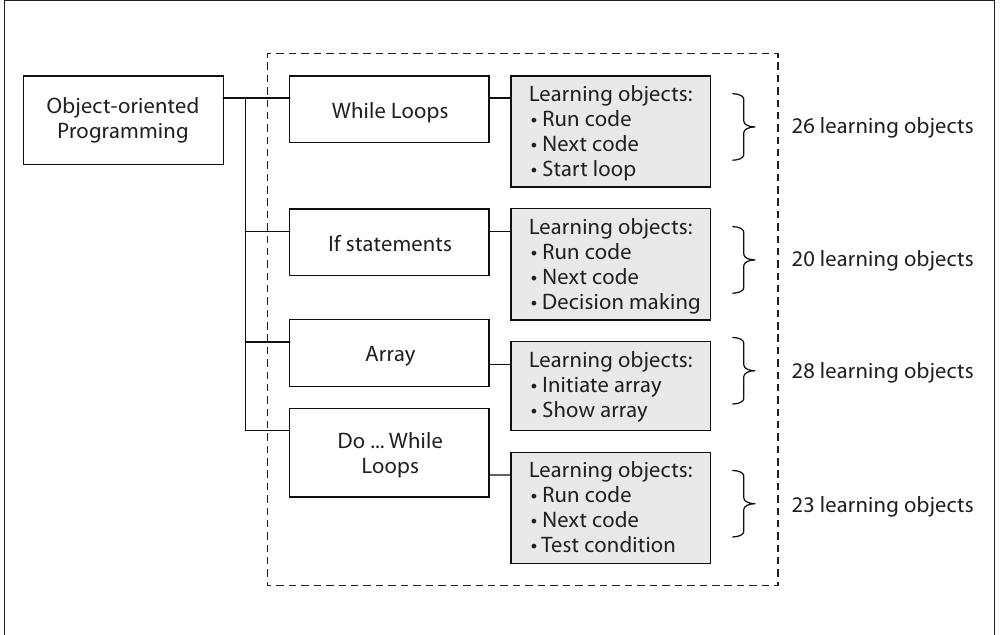
Figure 4 Knowledge map structure constructed using concept